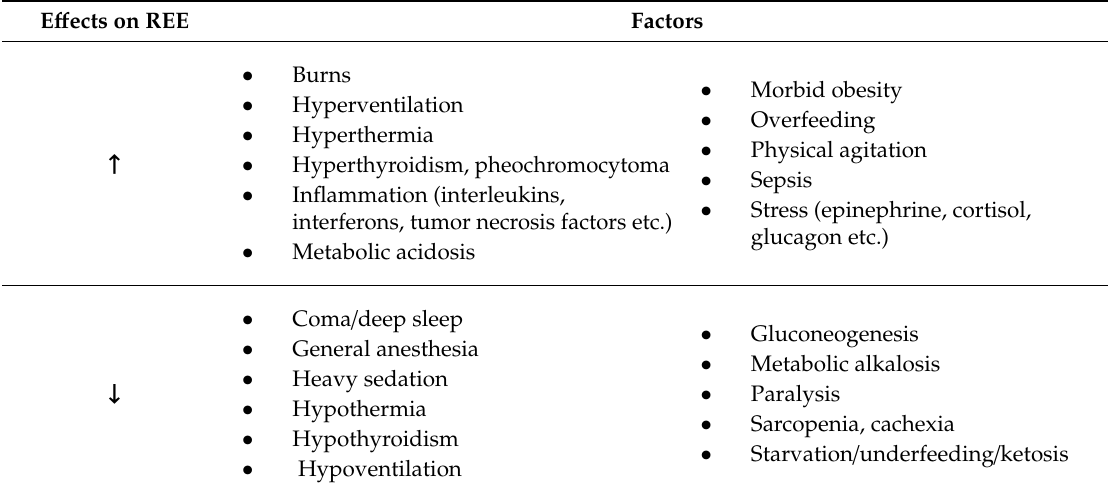
Table 1. Factors influencing resting energy expenditure. Adapted from [1,2,9]. E ff ects on